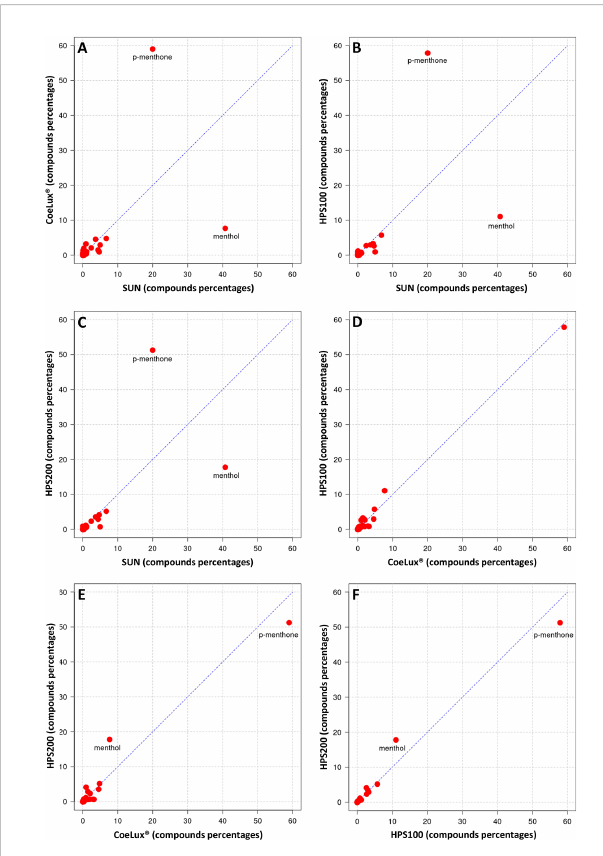
FIGURE 9 Cross-plot comparison of the biochemical composition in the essential oil of O. basilicum plants grown under different light treatments. Respectively, (A) CoeLux® vs SUN, (B) HPS100 vs SUN, (C) HPS200 vs SUN, (D) HPS100 vs CoeLux®, (E) HPS200 vs CoeLux®, and (F) HPS200 vs HPS100. Points away from the bisector represent molecules differentially expressed in the two light treatments under analysis, while points on the bisector represent molecules present in the same percentage in both